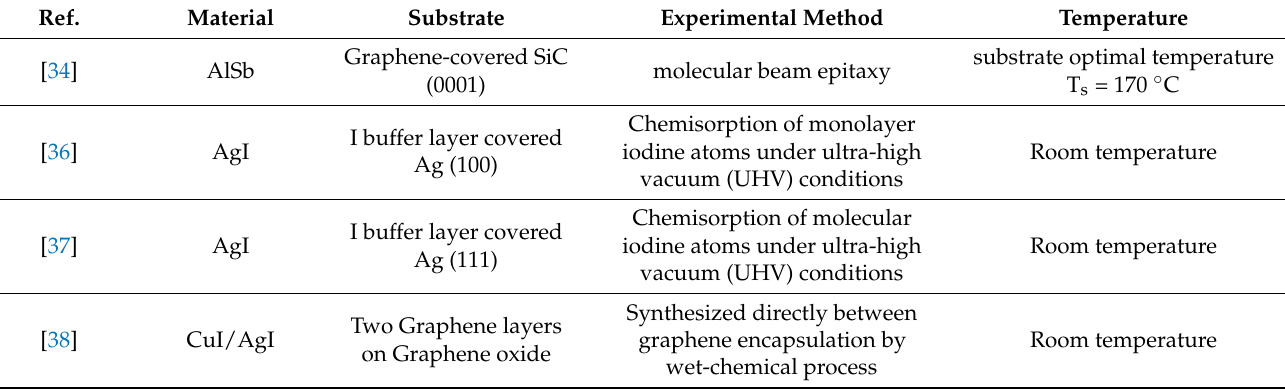
Table 1. Experimental conditions of the growth of different DLHC materials.